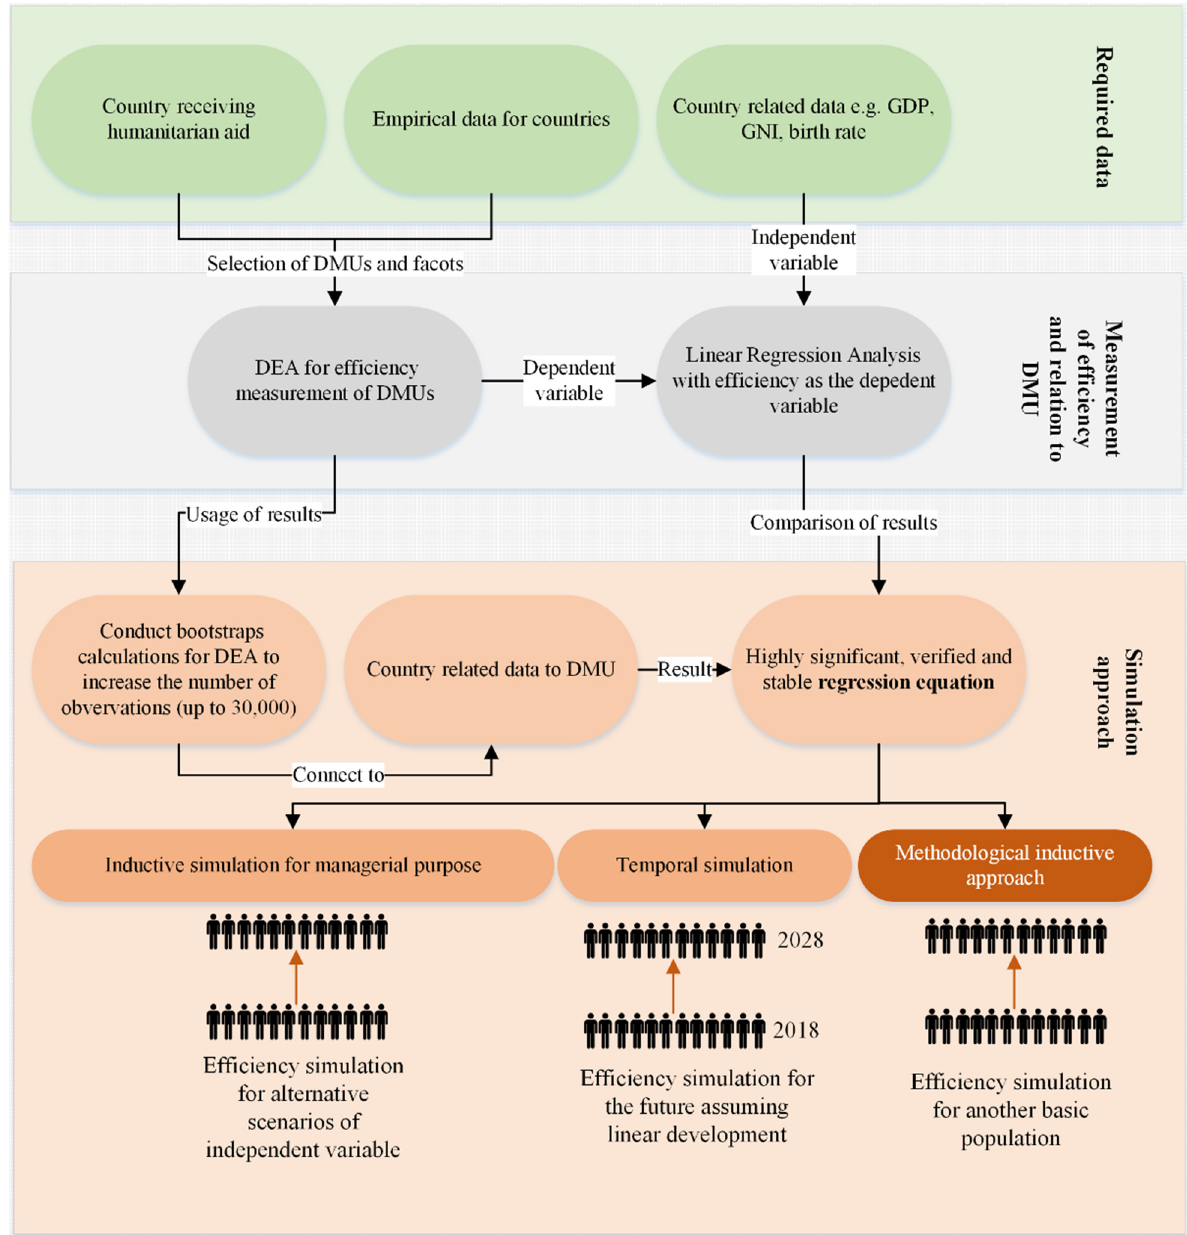
Figure 4. Requirements, techniques, and outcomes for a simulation approach.—Note: GDP (gross domestic product); DMU (Decision making unit); DEA (Data Envelopment Analysis.